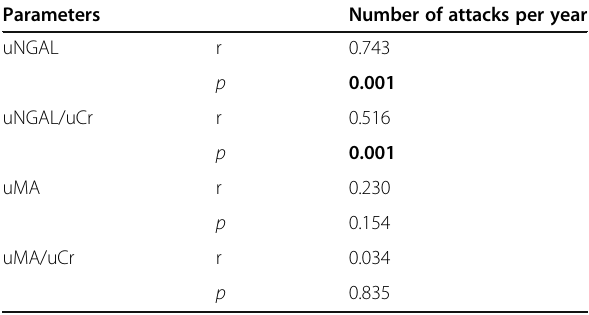
Table 4 The relations of uNGAL, uNGAL/uCr, uMA and uMA/Cr with number of attacks per year in familial Mediterranean fever